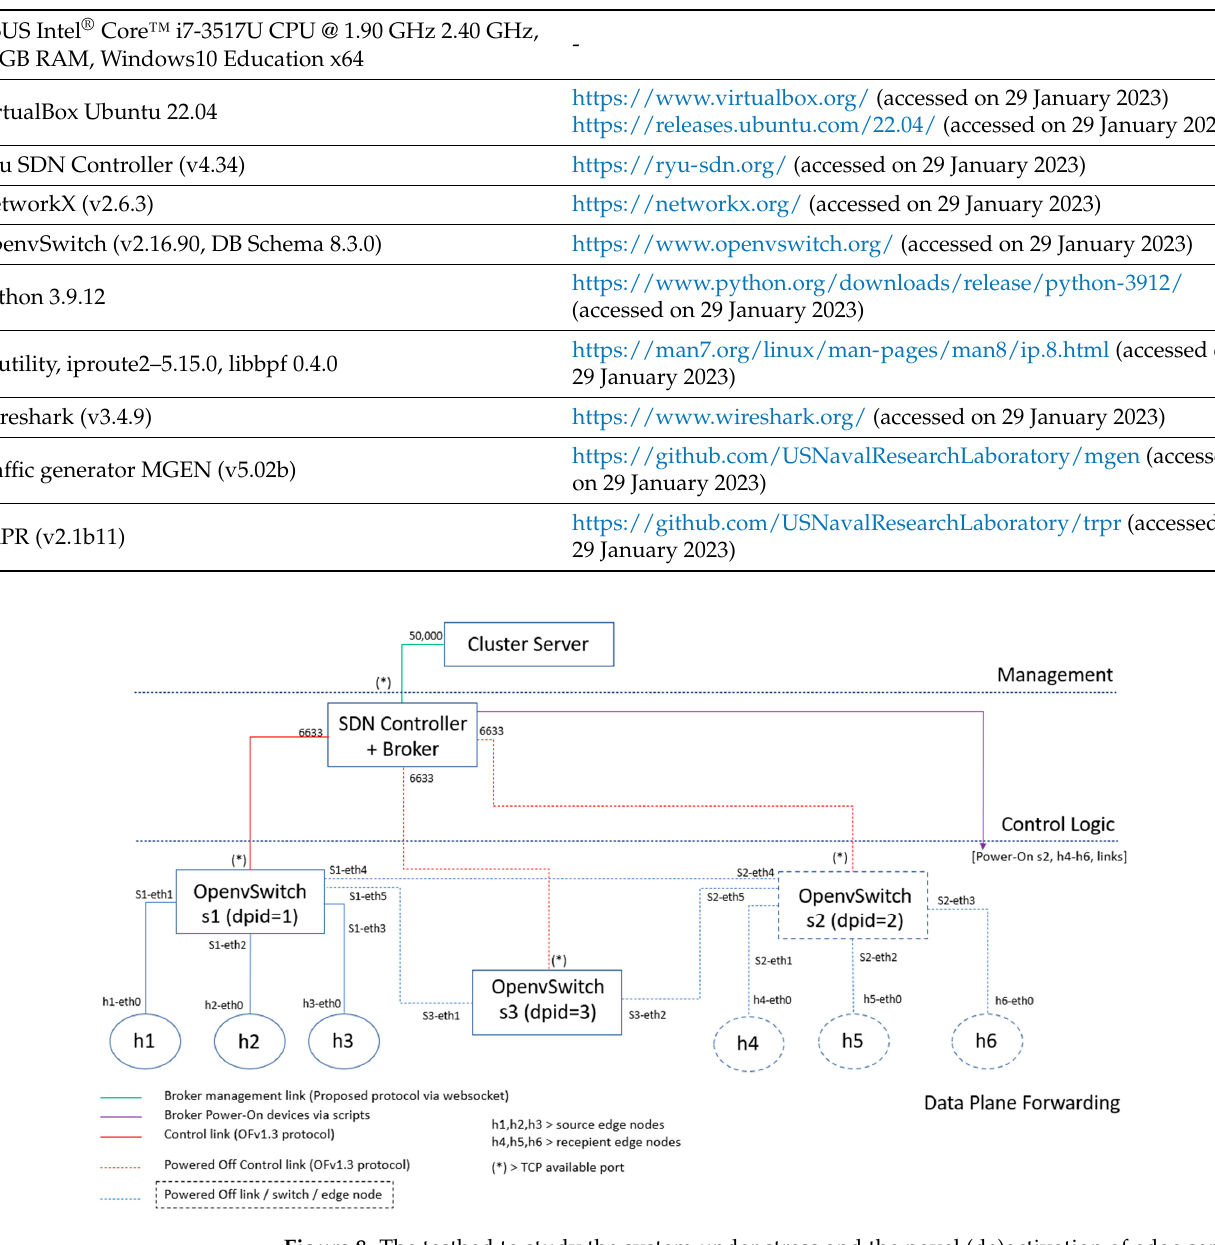
Figure 8. The testbed to study the system under stress and the novel (de)activation of edge serv-